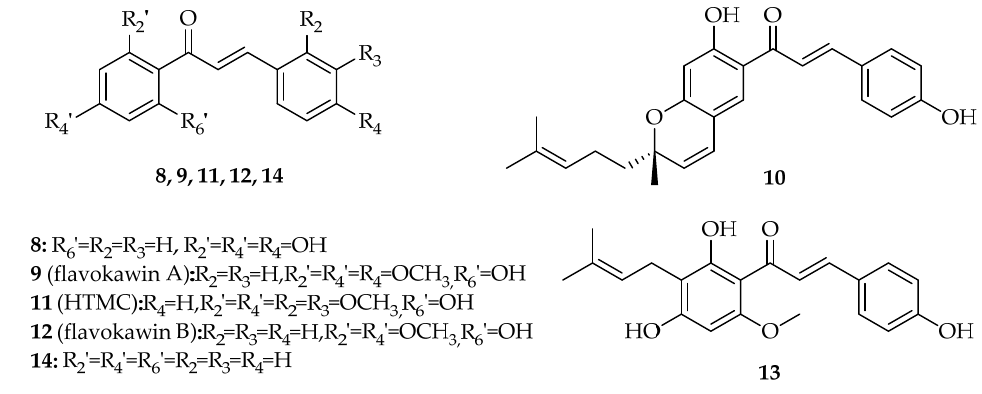
Figure 4. Natural chalcones interfering with p53 pathway.